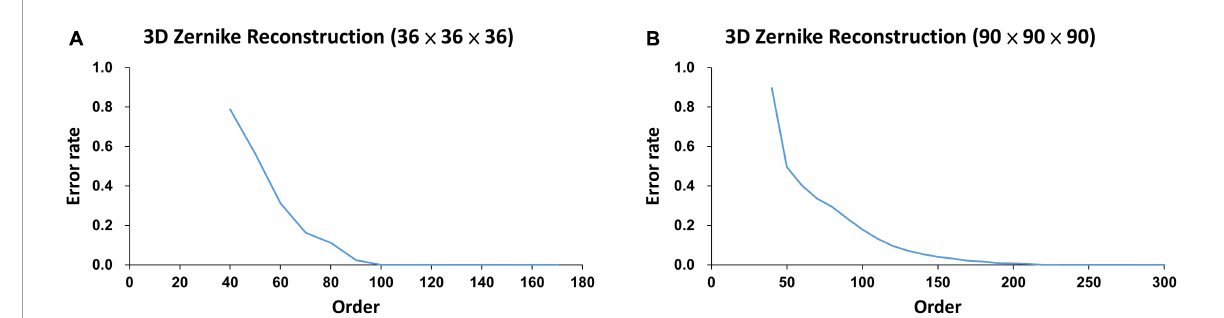
FIGURE4 The error rates of two lesions calculated from two different normalized sizes at different Zernike reconstruction orders: (A) the error rate of an 80-voxel lesion in a 36 × 36 × 36 voxel cube approached zero at order around 100, and (B) the error rate of a 1500-voxel lesion in a 90 × 90 × 90 voxel cube approached zero at order around 250.